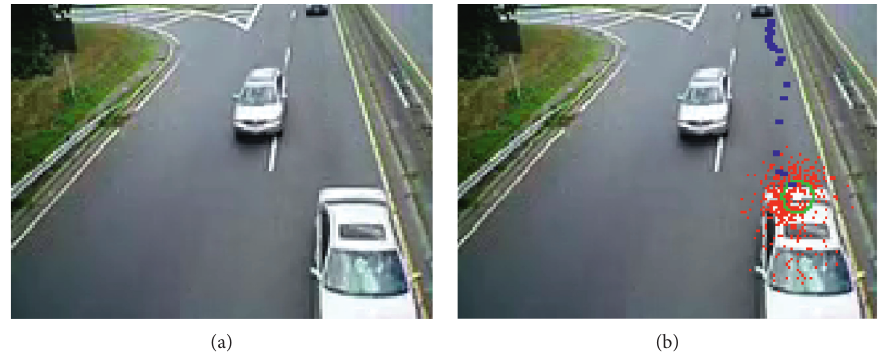
Figure 12: Tracking result of the 20 th frame. (a) The original image. (b) Tracked vehicle